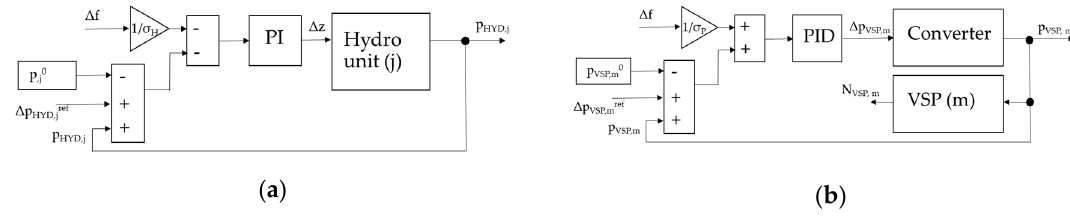
Figure 2. Block diagram of hydro units ( a ) and Variable Speed Pumps (VSPs) ( b ) control loop.